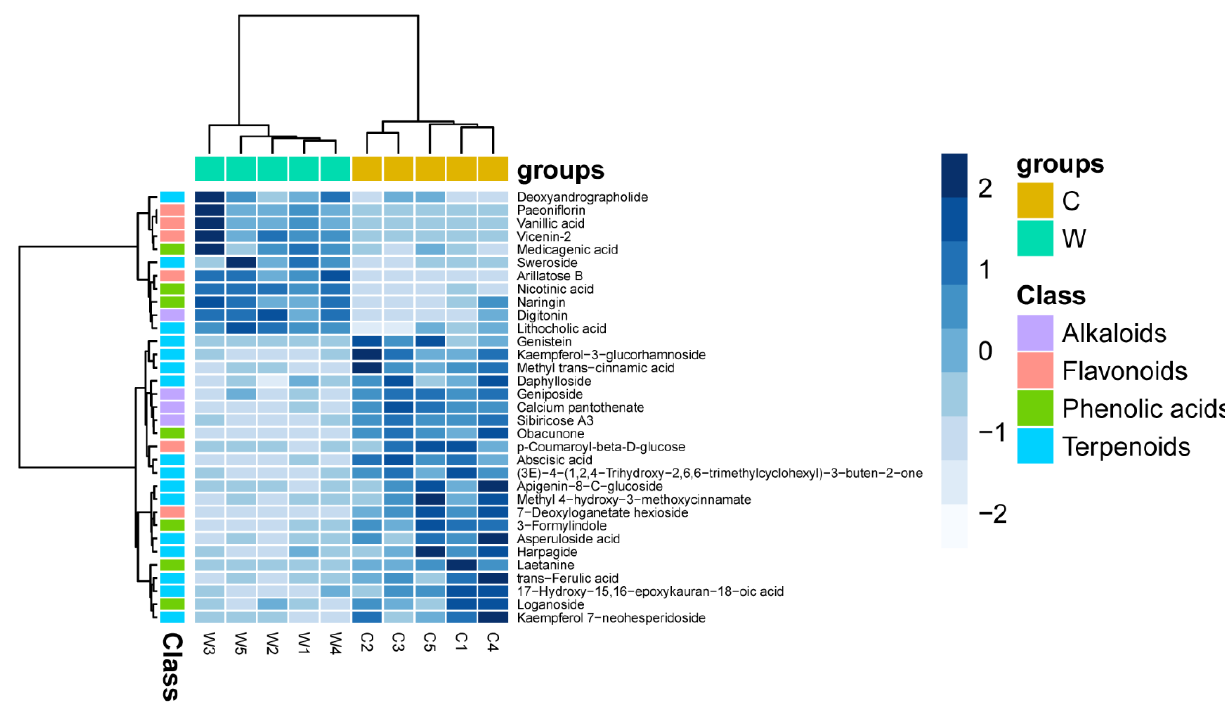
Figure 5. Heatmaps and hierarchical cluster analysis of the 33 significantly altered phytochemicals.